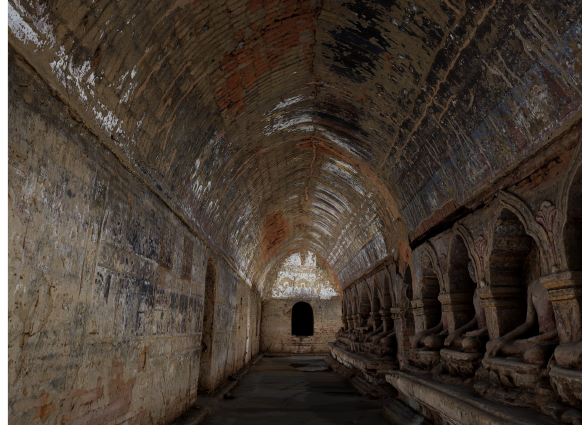
Figure 4. Render of the interior photogrammetry of Myin-pya-gu.